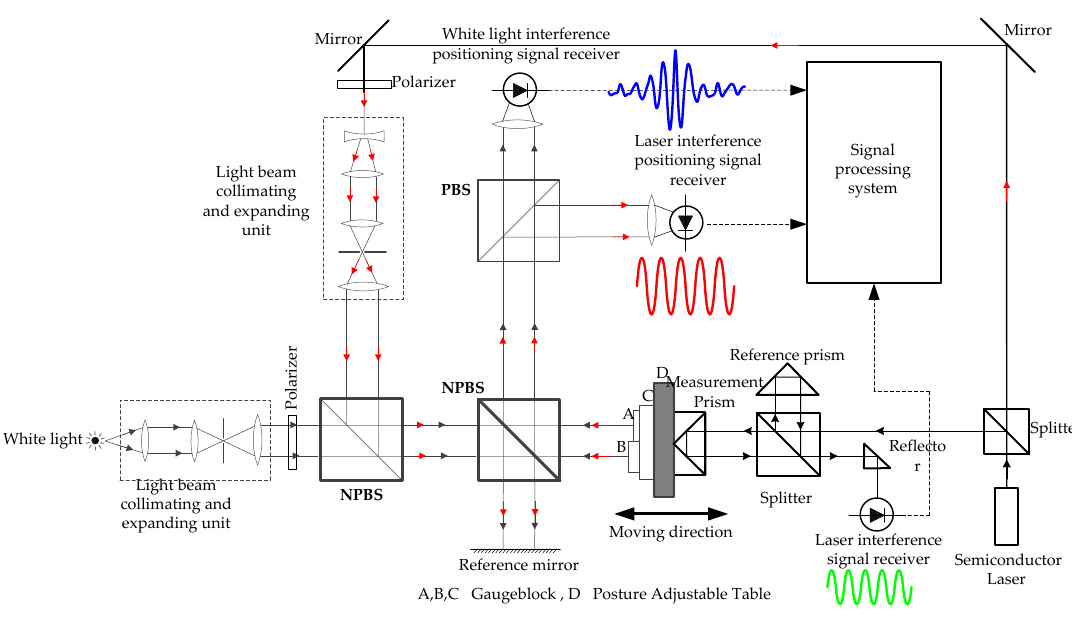
Figure 1. Block diagram of the system.